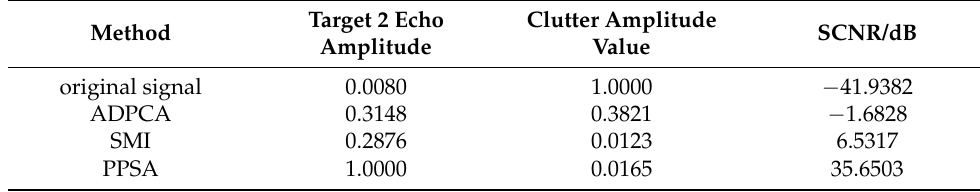
Table 15. SCNR comparison of target 2.